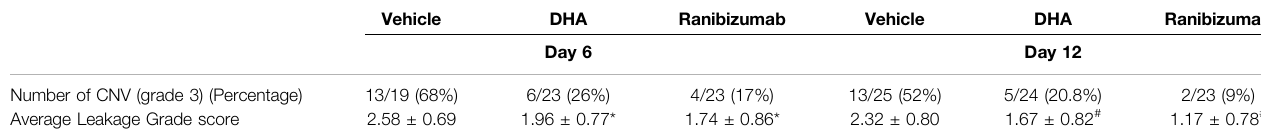
TABLE 1 | CNV leakage grading.